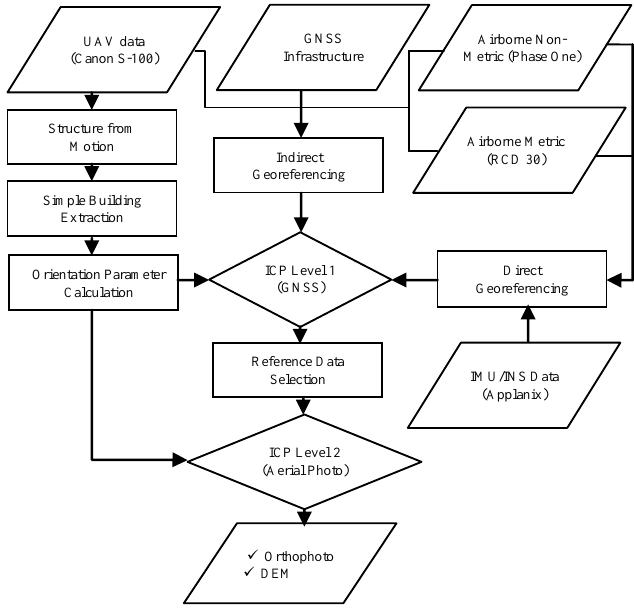
Figure 1. Workflow applied for this